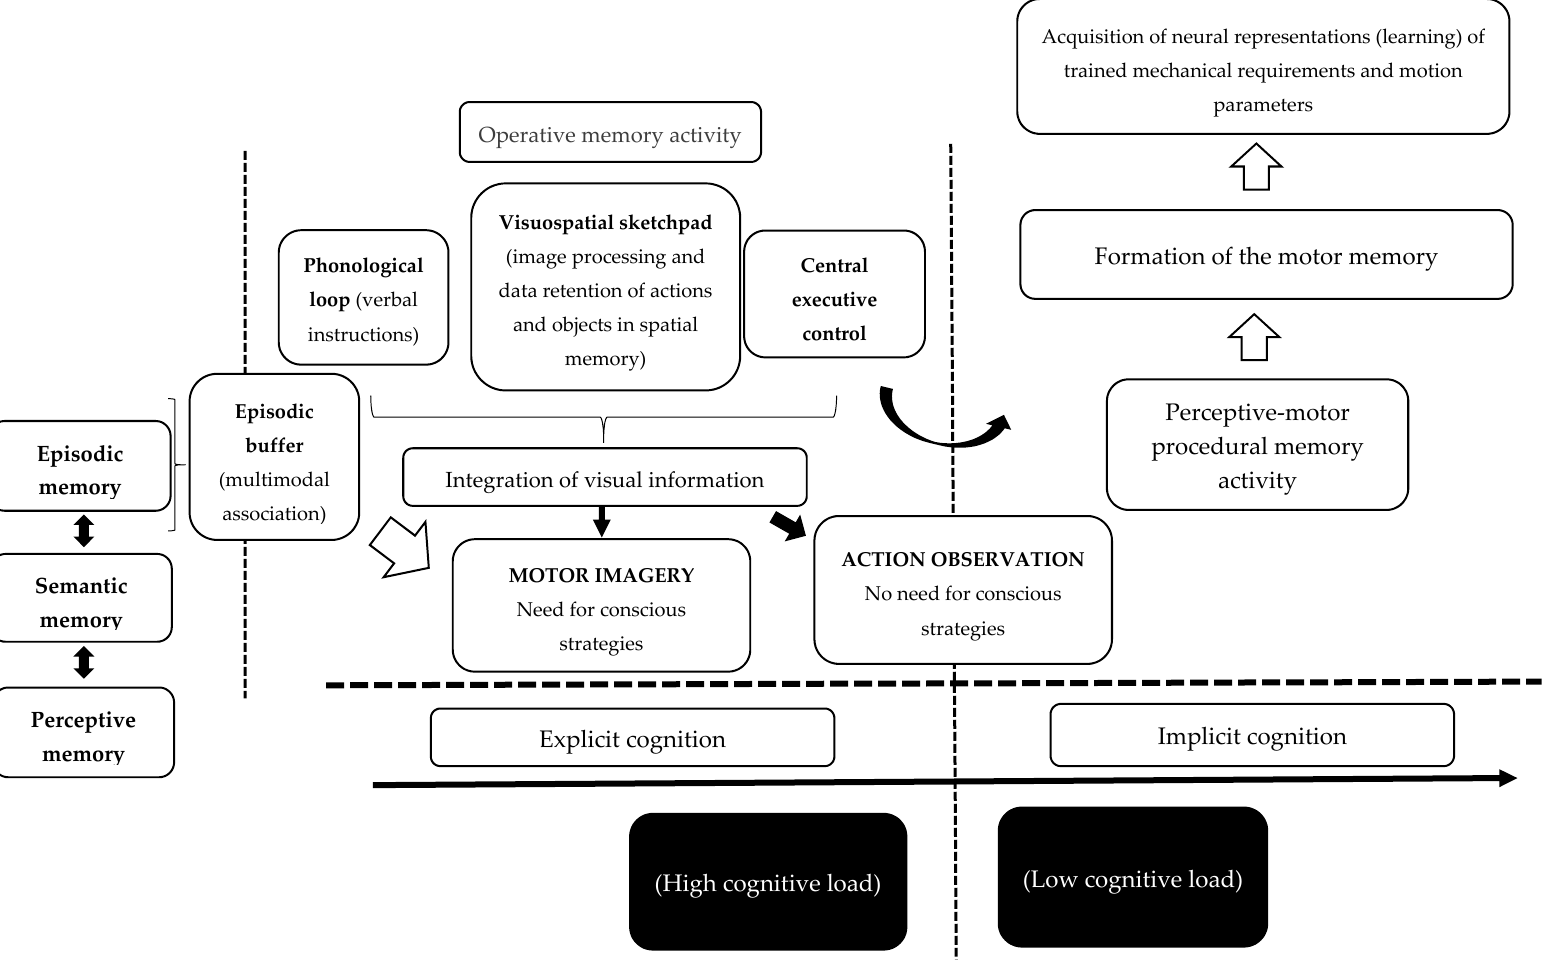
Figure 2. Functioning and acquisition of mnemonic